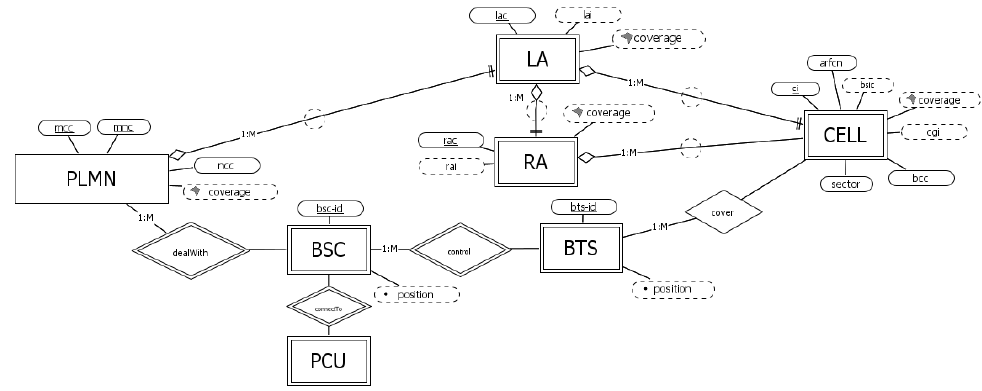
Figure 3. Conceptual schema for GSM networks.